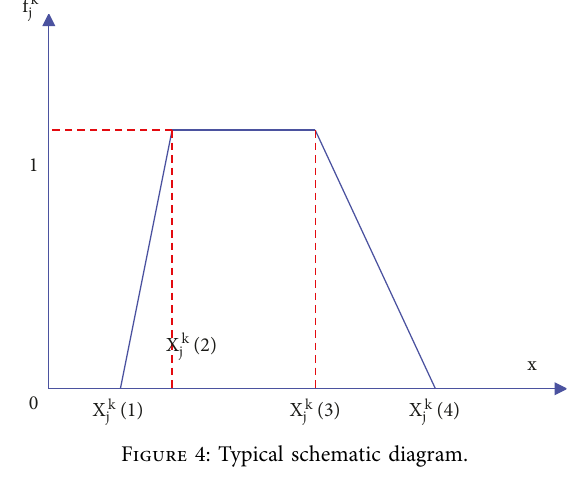
Figure 4: Typical schematic diagram.